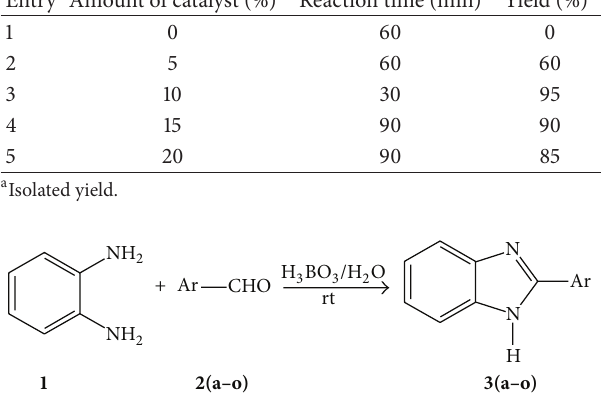
Scheme 1: Synthesis of benzimidazoles using boric acid as